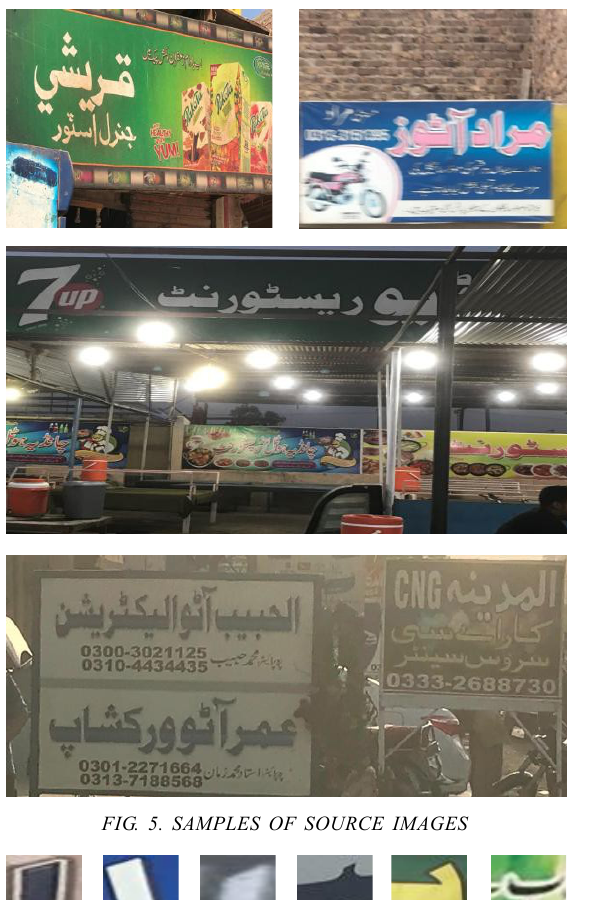
FIG. 7. SAMPLES OF URDU TEXT CROPPED WORD- IMAGES IN NATURAL SCENES